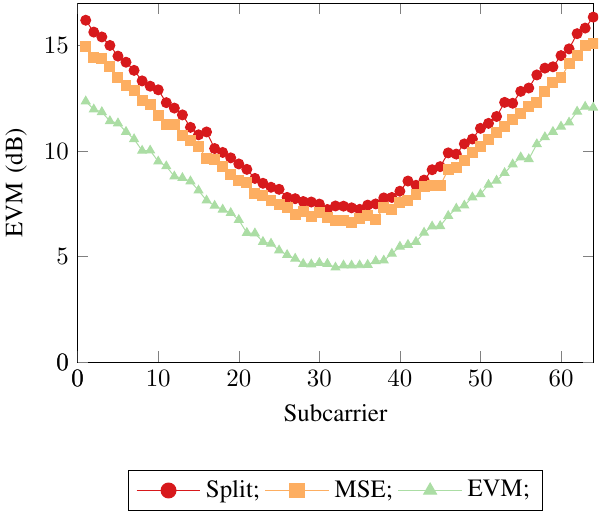
Figure 5. Error vector magnitudes across the subcarriers for the three neural network receiver approaches for orthogonal frequency division multiplexing